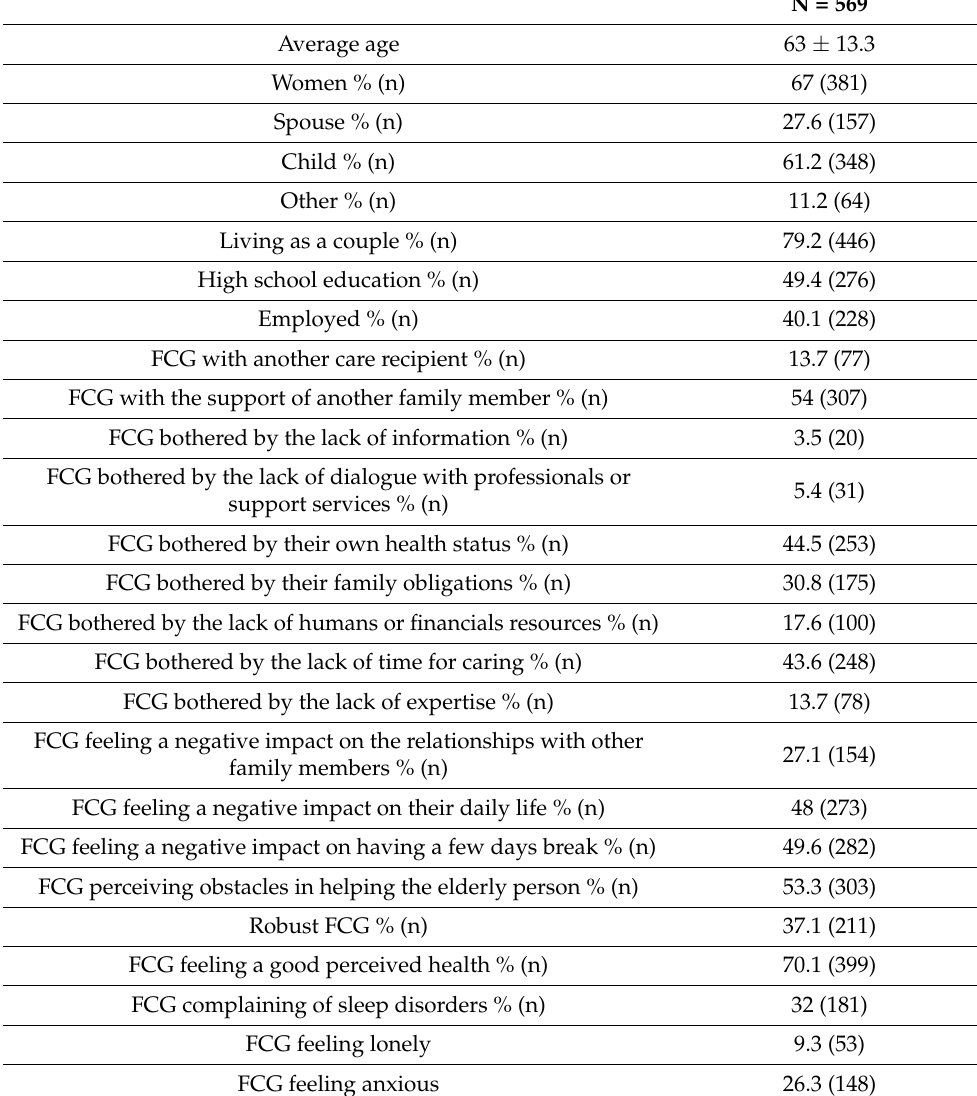
Table 2. Profile of FCGs